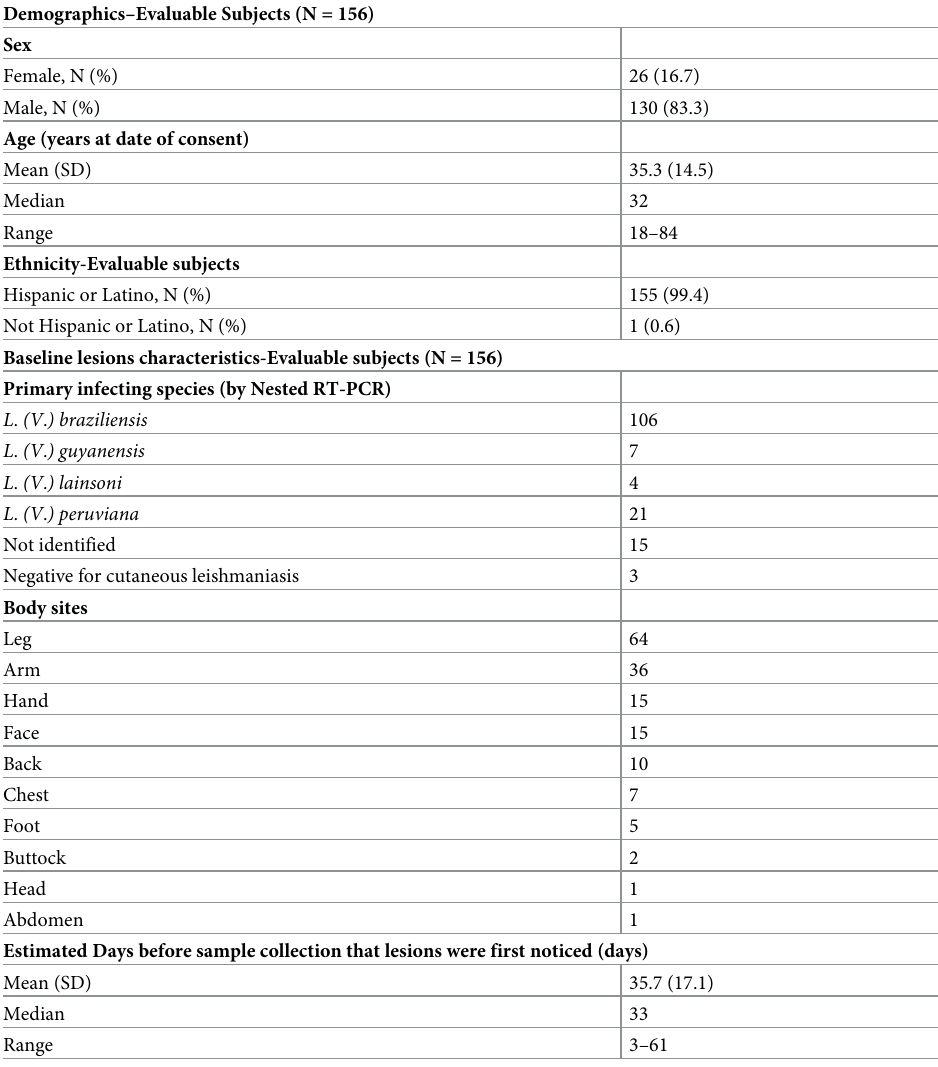
Table 1. Demographic and Other Baseline